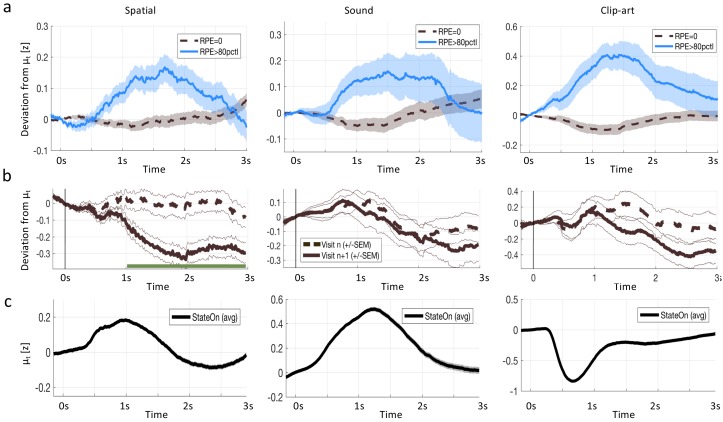
Reward prediction error (RPE) at non-goal states modulates pupil dilation.Pupil traces (in units of standard deviation) from all states except G were aligned at state onset (t=0⁢m⁢s) and the mean pupil response μt was subtracted (see Materials and methods). (a) The deviation from the mean is shown for states where the model predicts R⁢P⁢E=0 (black, dashed) and for states where the model predicts R⁢P⁢E≥80t⁢h percentile (solid, blue). Shaded areas: ± SEM. Thus the pupil dilation reflects the RPE predicted by a reinforcement learning model that spreads value information to nonrewarded states via eligibility traces. (b) To qualitatively distinguish pupil correlations with RPE from correlations with state values V⁢(s), we started from the following observation: the model predicts that RPE decreases over the course of learning (due to convergence), while the state values V⁢(s) increase (due to spread of value information). We wanted to observe this qualitative difference in the pupil dilations of subsequent visits of the same state. We selected pairs of visits n and n+1 for which the RPE decreased while V⁢(s) increased and extracted the pupil measurements of the two visits (again, mean μt is subtracted). The dashed, black curves show the average pupil trace during the nt⁢h visit of a state. The solid black curves correspond to the next visit (n+1) of the same state. In the spatial condition, the two curves significantly (p<F⁢D⁢Rα=0.05) separate at t>1⁢s (indicated by the green line). All three conditions show the same trend (with strong significance in the spatial condition), compatible with a positive correlation of pupil response with RPE, but not with state value V⁢(s). (c) The mean pupil dilation μt is different in each condition, whereas the learning related deviations from the mean (in (a) and (b)) have similar shapes.